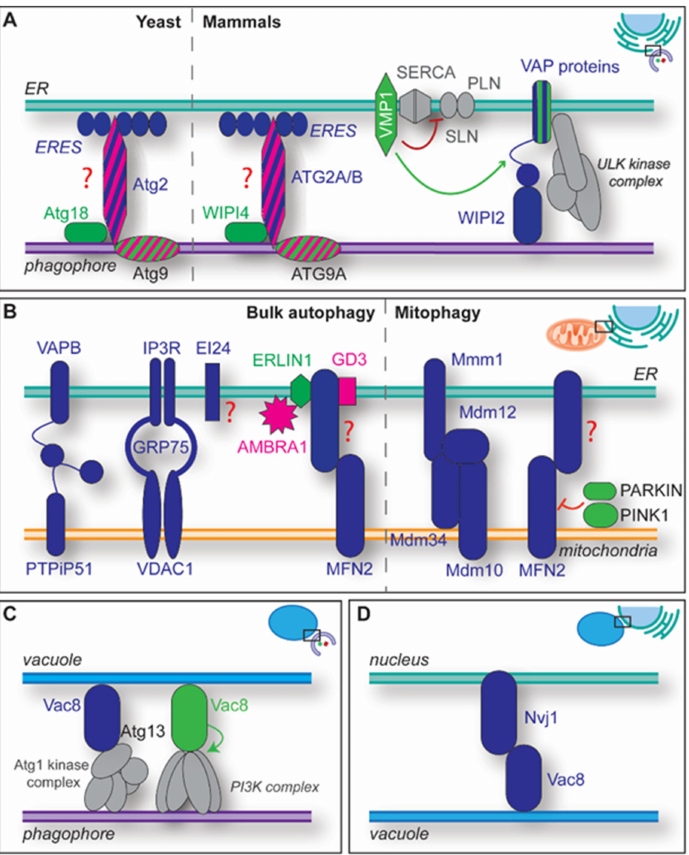
Figure 3. Overview of some of the MCSs playing a relevant role in autophagy. ( A ) One type of ER- phagophore MCSs involve Atg2/ATG2A/ATG2B, Atg9/ATG9A, Atg18/WIPI4 and the ERES. The Atg2/ATG2A/ATG2B tether partner at the ERES remains to be identified, which is indicated by the red question mark. Atg2/ATG2A/ATG2B very likely supply the phagophore with lipids. In addition to probably assisting the transfer of lipids by ATG2 proteins, the VMP1 lipid scramblase exerts a regulatory role at the phagophore-ER MCSs by preventing the inactivation of the ER-localized calcium pump SERCA (red line) by PLN/SLN binding (red arrow). VMP1 also appear to be a regulator (green arrow) of MCSs between the phagophore and the ER by modulating the interaction between VAP proteins and both FIP200, which stabilizes the ULK kinase complex (grey) at the omegasome, and WIPI2. ( B ) ER-mitochondria MCSs and MAMs are central for autophagosome biogenesis and several of them have been described. Their interrelationship remains largely unknown, i.e., it is unclear if the different MAMs implicated in autophagy are part of the same MCSs. VAPB and PTPIP51 form one of the MAM tethers, the complex of VDAC1, IP3R and GRP75 another one. EI24 interacts with the subunits of this complex, indicated by the grey dashed lines, and is required for normal autophagic flux. However, the role of EI24 in autophagy is mechanistically not well understood, represented by the red question mark, although a very recent study connects it to calcium signaling [83]. The tether MFN2 forms complexes with GD3, its binding partner, ERLIN1, and AMBRA1 in MAM-specific lipid- microdomains, to regulate autophagosome biogenesis. ERLIN1 and GD3 are associated to lipid-rafts in the ER, and ERLIN1 and AMBRA1 interact in those. AMBRA1 is phosphorylated by ULK1 upon autophagy induction and recruits the autophagy-specific PI3K complex to the omegasome. In yeast, the ERMES formed by Mdm10, Mdm12, Mdm34 and Mmm1 are key for mitophagy progression.